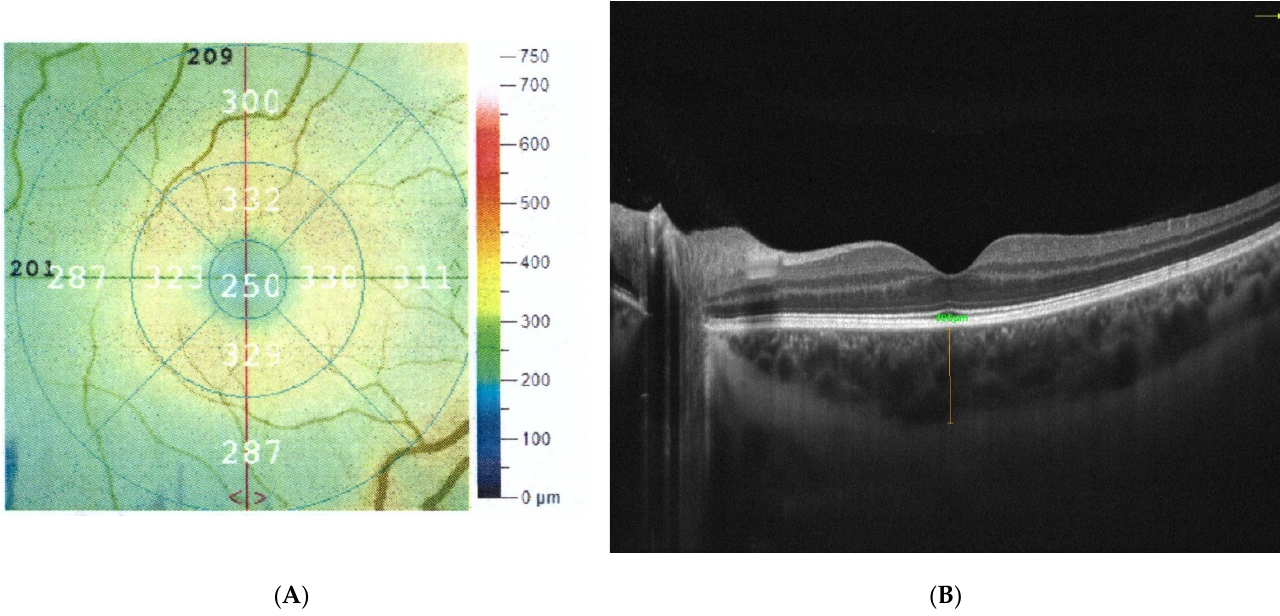
Figure 3. Example of a study of retinal thickness ( A ) and choroidal thickness ( B ).